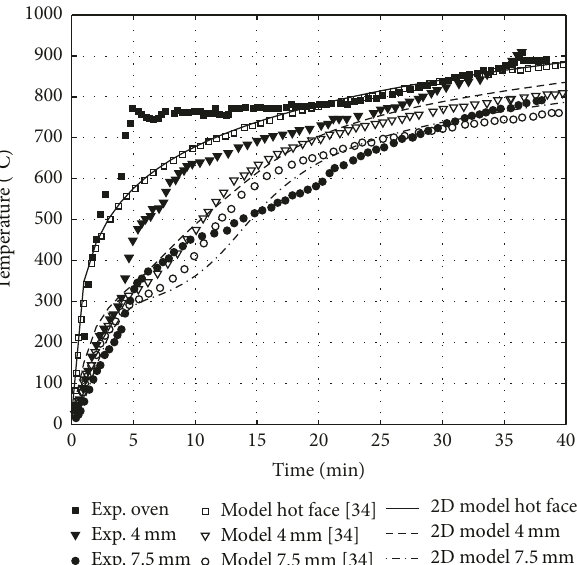
Figure 3: Comparisons of temperature progressions of bottom flange.